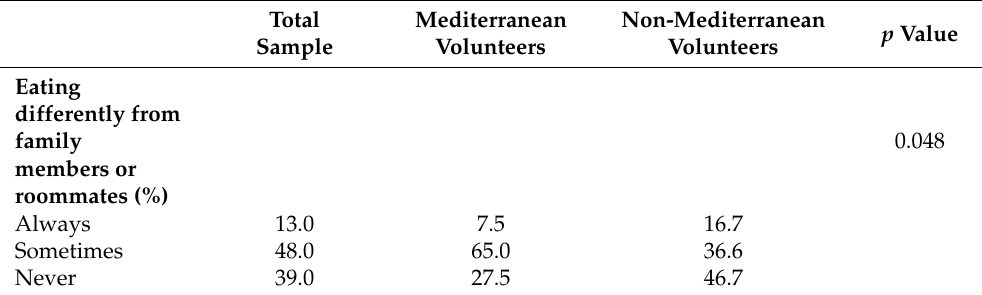
Table 6. Eating differently from family members or roommates by geographical area of